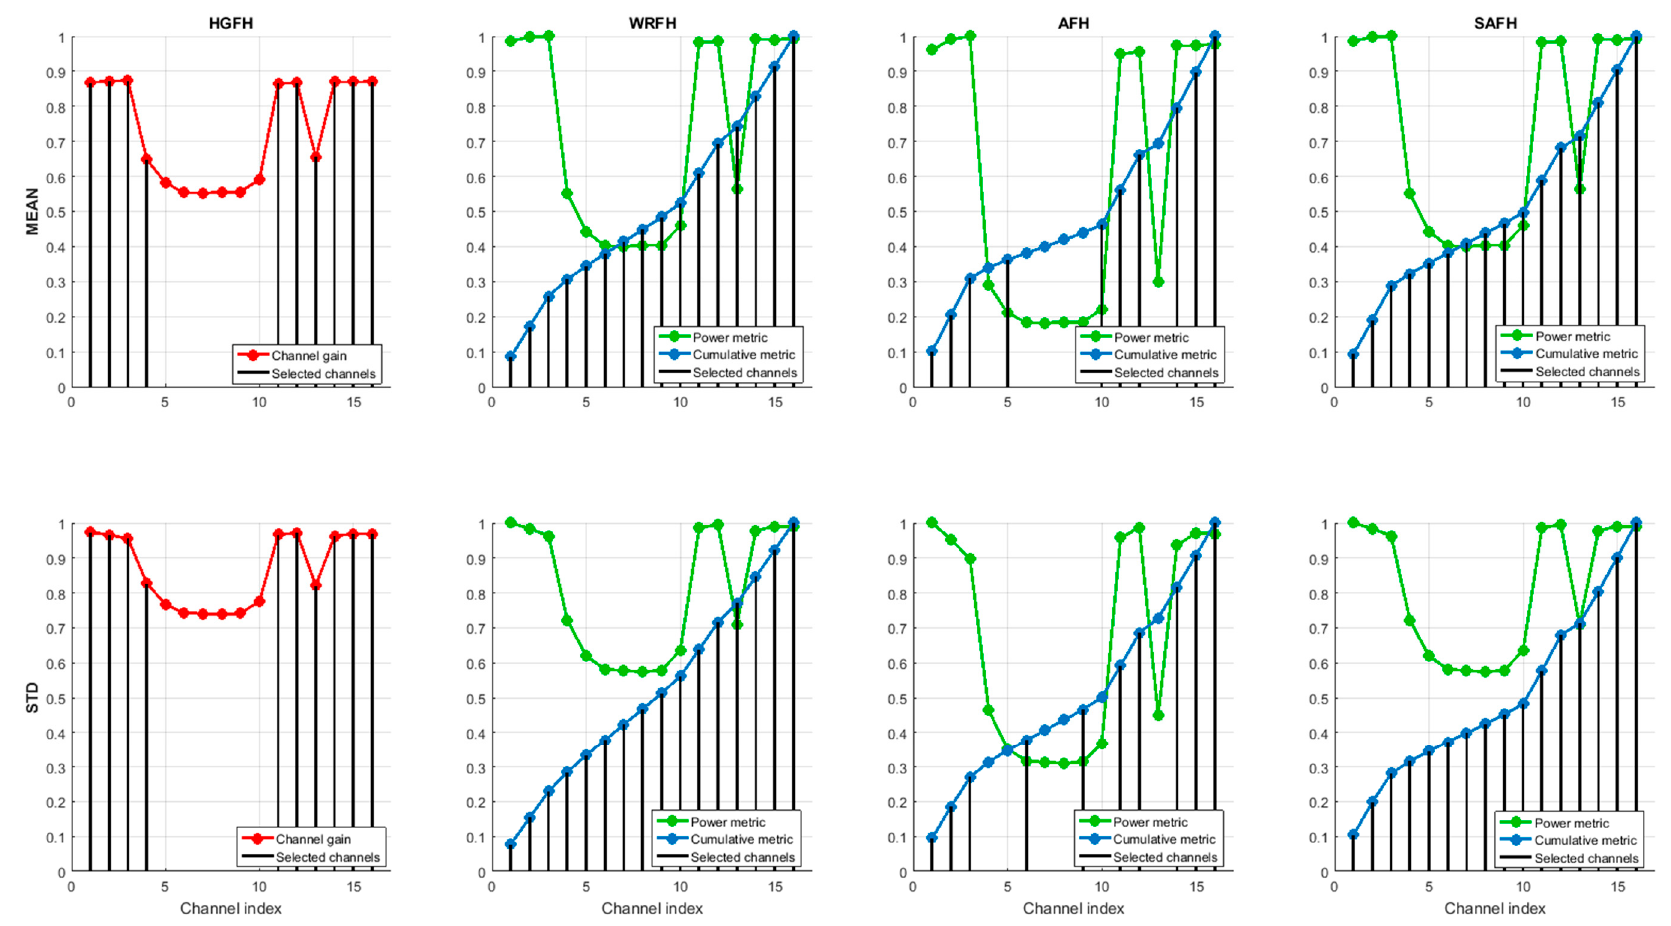
Figure 19. Channel selection. HGFH technique directly uses the channel gain (red) to select the 10 best channels. WRFH, AFH and SAFH techniques use the cumulative metric (blue) derived from the power metric (green) to select the best channels. In all the case, the selected channels are represented as vertical black lines.